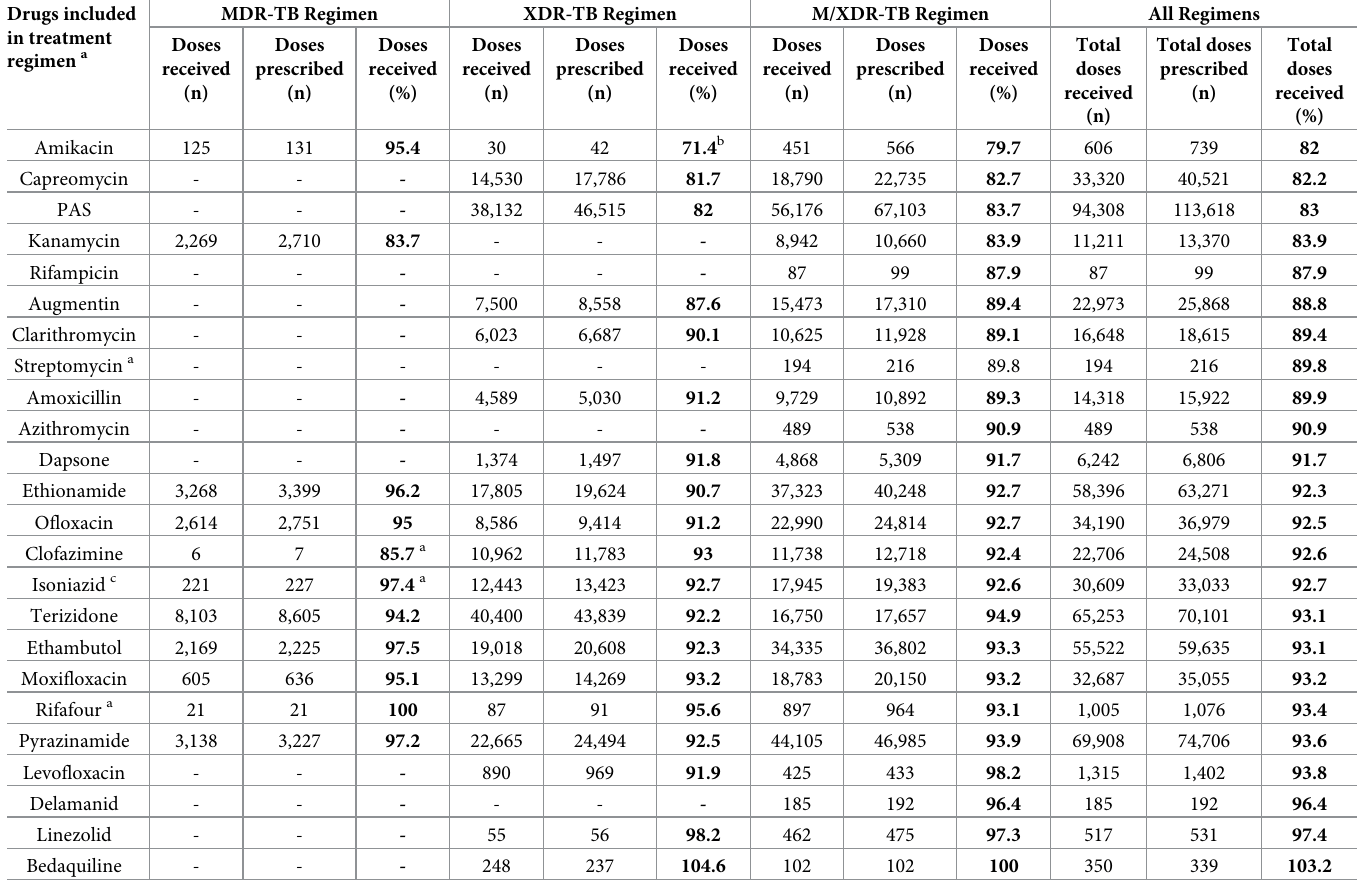
Table 2. Percent received doses of anti-TB drugs. Summary of percent hospital-based anti-TB drug doses received categorized by drug-resistant TB regimen, in order of lowest to highest overall percent doses received, for all regimens. Drugs included in